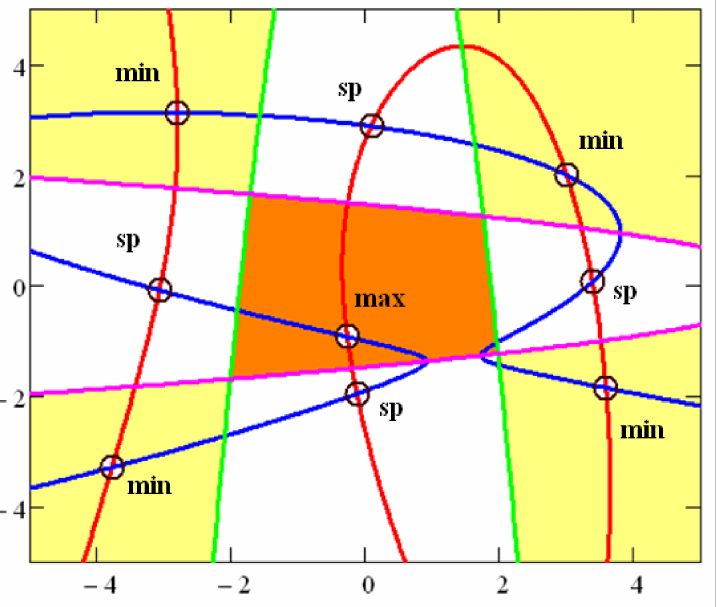
Figure 30. Visualization of the necessary conditions for the existence of extrema of the Himmelblau’s